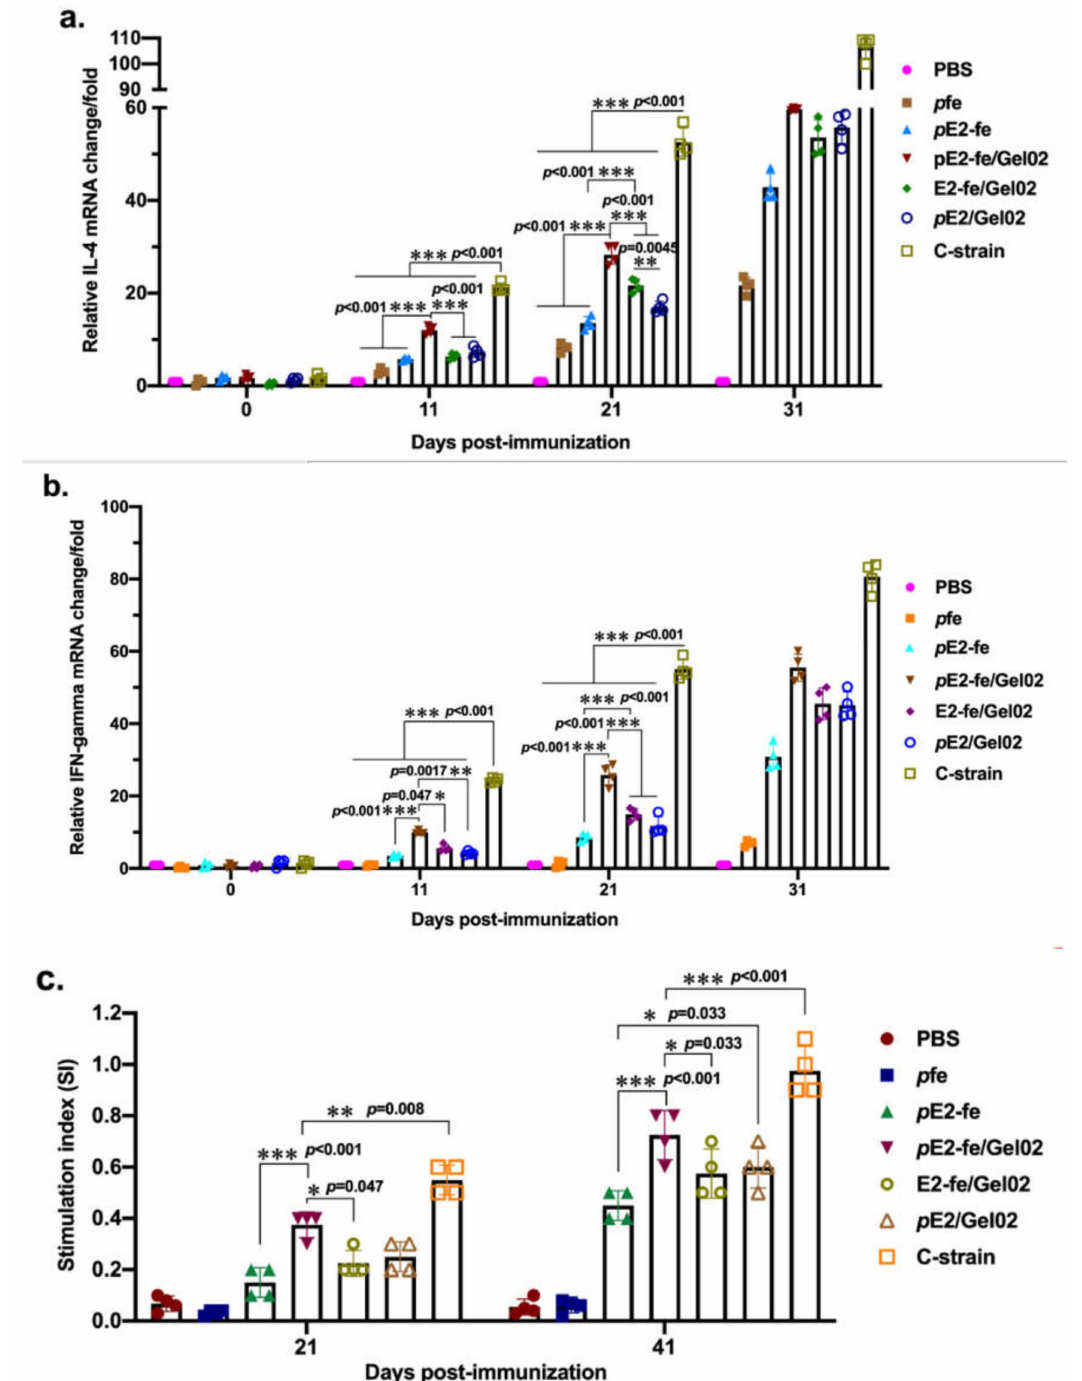
Figure 4. The humoral and cellular immunity response detection. ( a ) Relative IL-4 mRNA fold change detection by RT-qPCR. ( b ) Relative IFN- γ mRNA fold change detection by RT-qPCR. ( c ) Lymphocyte proliferation assay for cell viability determination via MTT. All the data in this figure are repeated 4 times. The data presented here were analyzed by two-way ANOVA assay using GraphPad Prism 8.0. *, 0.05 < p < 0.01; **, 0.01 < p < 0.001; ***, p <